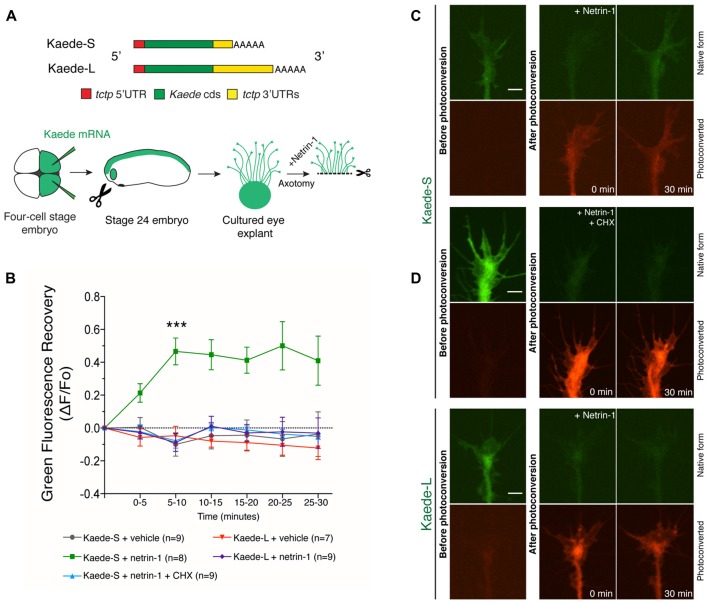
Netrin-1-induced translation reporter synthesis reveals 3′untranslated region (3′UTR) isoform dependancy. (A) Schematic of Kaede constructs and experimental design. In vitro transcribed mRNAs encoding Kaede-S or Kaede-L were introduced by blastomere injection and stage 24 eye explants cultured for 14–18 h before imaging. Kaede-positive axons were severed from their cell bodies before green-to-red UV-photoconversion and continually examined for signs of cell death (e.g., fragmentation along the axon shaft) thereafter. (B) Quantification of green fluorescence recovery over multiple time-lapse sequences (mean ± SEM; n = no. of growth cones analyzed; ***P < 0.0001, two-way ANOVA and Bonferroni). (C,D) Pre- and post-photoconversion images of severed axons expressing Kaede-S or Kaede-L. Fluorescence recovery in response to Netrin-1 was only observed in Kaede-S-expressing neurons, and this effect was prevented by CHX treatment. Scale bars: 5 μm.